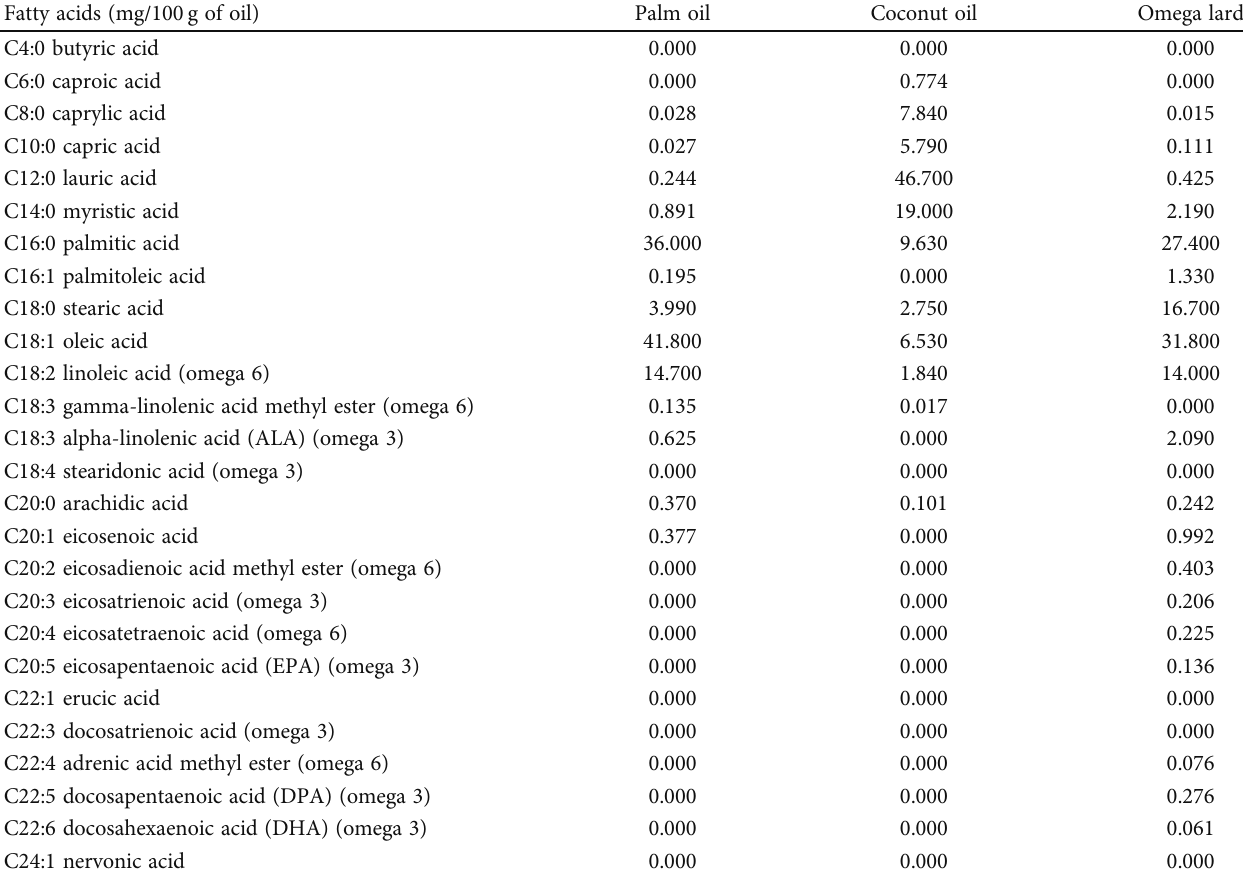
Table 1: Fatty acid composition of the oils used in this study.